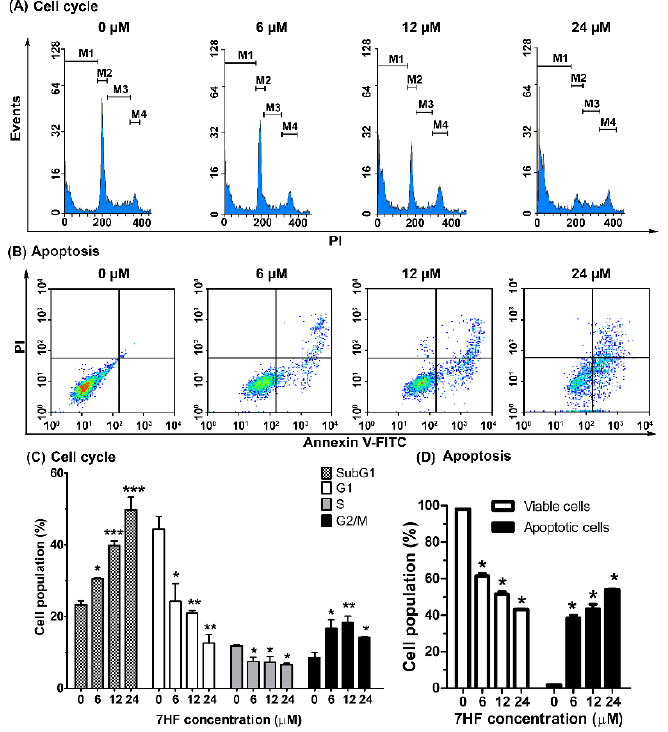
Figure 2. 7- α -hydroxyfrullanolide (7HF) induces cell cycle arrest and apoptosis in triple-negative breast cancer cells. The cells were treated with or without 6, 12 and 24 µM 7HF for 24 h, stained with propidium iodide (PI) (for cell cycle analysis) and annexin V - fluorescein isothiocyanate (FITC) and PI (for apoptosis analysis) and analyzed using flow cytometry. ( A ) Representative histograms showing cell cycle distribution. The M1, M2, M3 and M4 annotations in the histograms represent cell populations in the sub - G1, G1, S and G2 / M phases, respectively. ( B ) Density plots showing differences in the plasma membrane integrity and permeability based on the number of viable, early apoptotic, late apoptotic, and necrotic cells detected in each 7HF treatment group, as shown in the lower left ( V − , PI − ) , lower right ( V + , PI − ) , upper right ( V + , PI + ) and upper left ( V − , PI + ) quadrants, respectively. ( C ) Data represent the mean ± SD values from two independent experiments of cell cycle analysis. ( D ) The proportion of viable and apoptotic cells was determined in two independent experiments. Differences were analyzed using one-way ANOVA and Tukey ’ s HSD multiple comparisons (* p < 0 . 05, ** p < 0 . 01, *** p < 0 . 001 ).